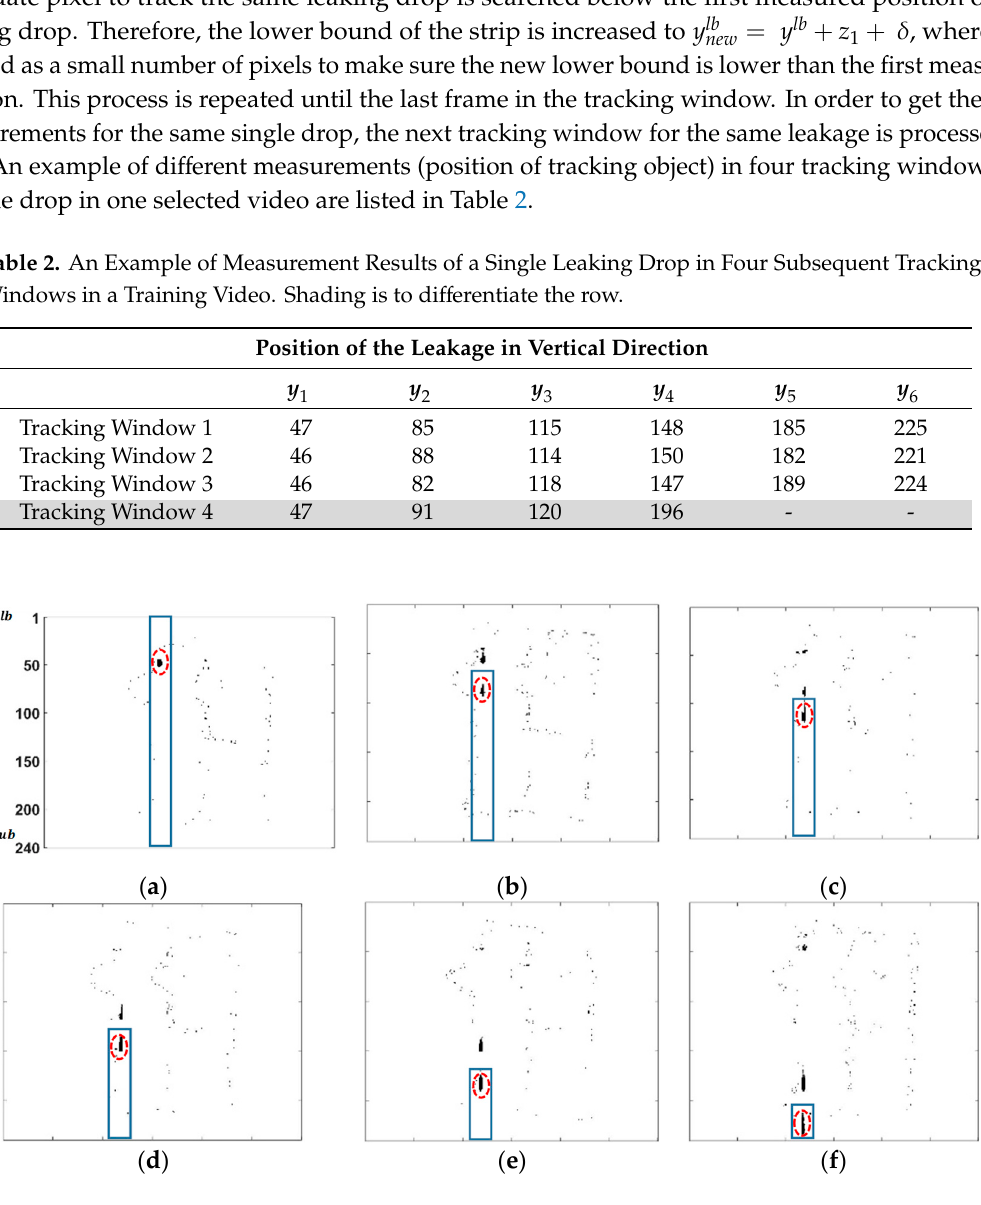
Figure 3. ( a – f ) Subsequent subtracted frames during an interval. The leaking drop is tracked based on its intesity and its neighbors along the strip. The lower boundry of the strip is increased to correctly measure the next position of the leaking drop.The tracked leaking drop is marked with dash-line circle.